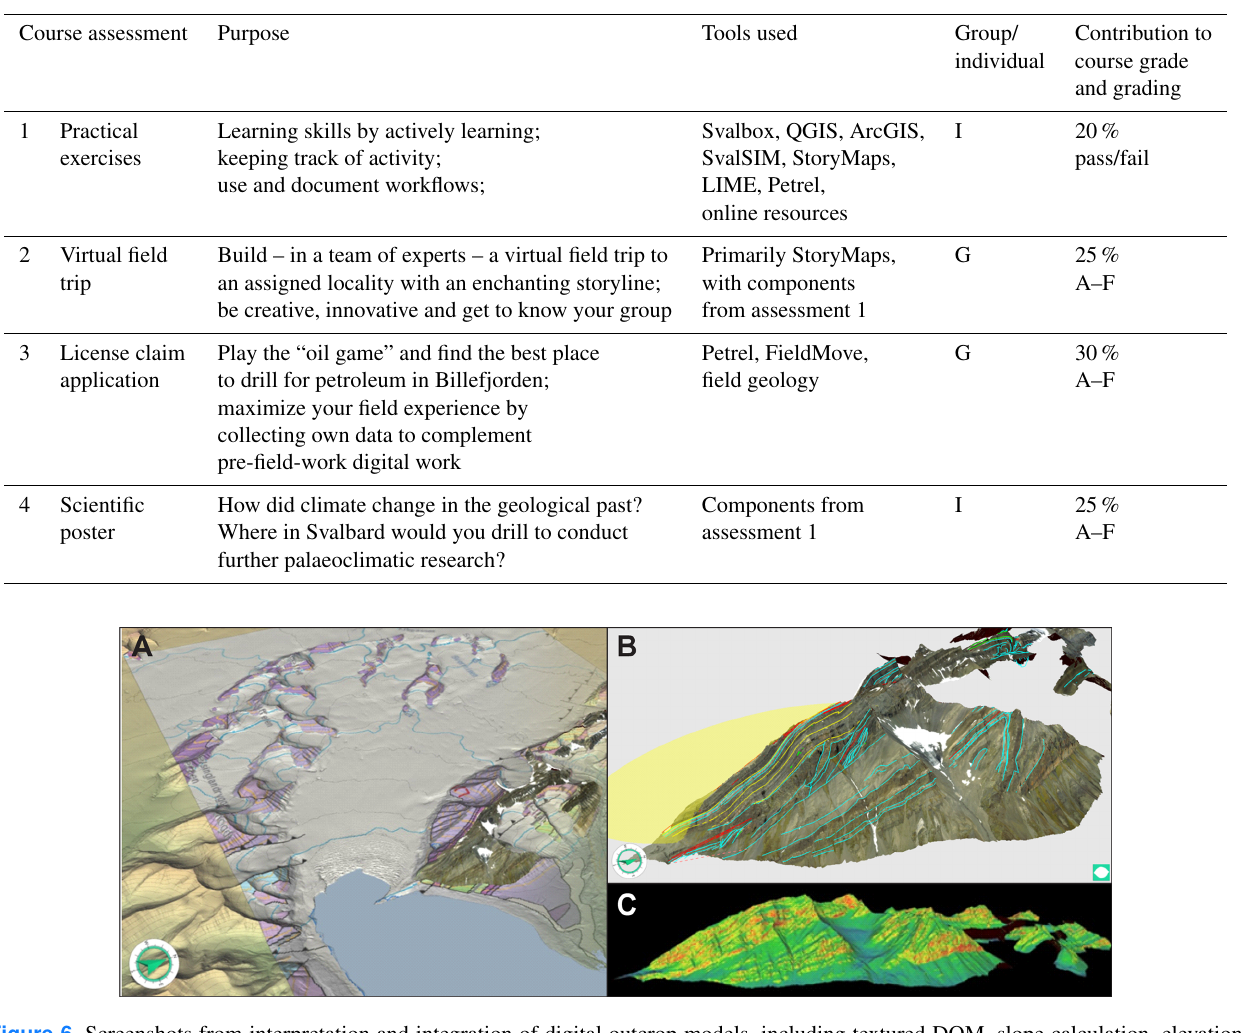
Figure 6. Screenshots from interpretation and integration of digital outcrop models, including textured DOM, slope calculation, elevation display and integration of the DOM with regional terrain models and geological maps. The illustrated example is from Mediumfjellet (https://v3geo.com/model/142, last access: 7 September 2021; details on the structural geology are in Larsen, 2010, and Strand, 2015). (a) Regional digital elevation model and geological map (both courtesy of Norwegian Polar Institute) overlain by Mediumfjellet DOM. (b) Close up of digital outcrop model, with interpretations by Strand (2015). (c) View of DOM from the south-east, with colour-coding representing the slope